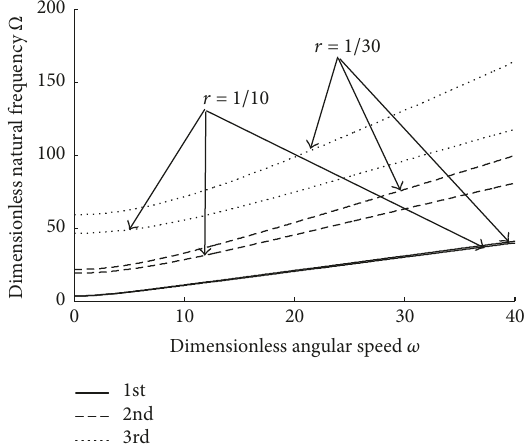
Figure 7: Variation of the first three dimensionless natural fre- quencies of rotating solid tapered beams with dimensionless angular speed of the hub for various 𝑟 = 1/30 , 1/10 at 𝜆 = 0.5 , 𝑟 0 = 0 .